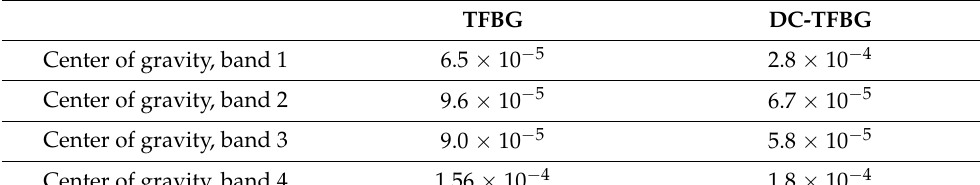
Table 3. Comparison of the resolution for the Hilbert envelope centre of gravity method for the TFBG and the DC-TFBG for optical spectra for individual frequency ranges. TFBG